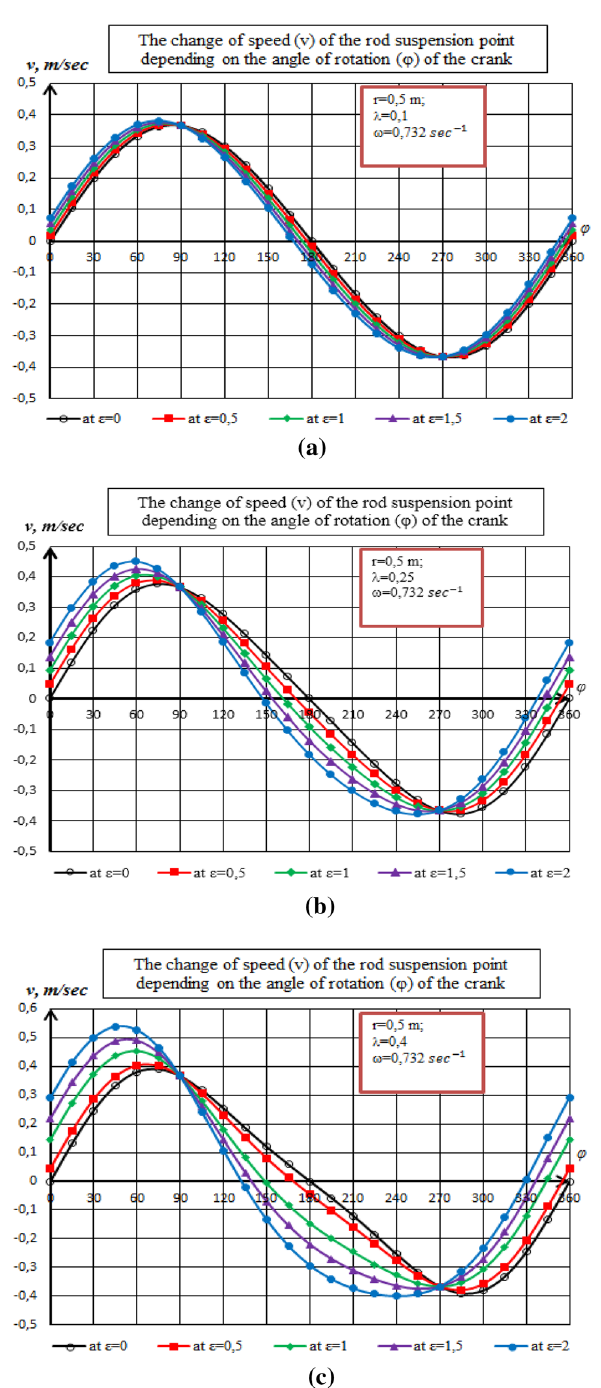
Fig. 2 The change of speed ( 𝜈 ) of the rod suspension point depending on the angle of rotation ( 𝜑 ) of the